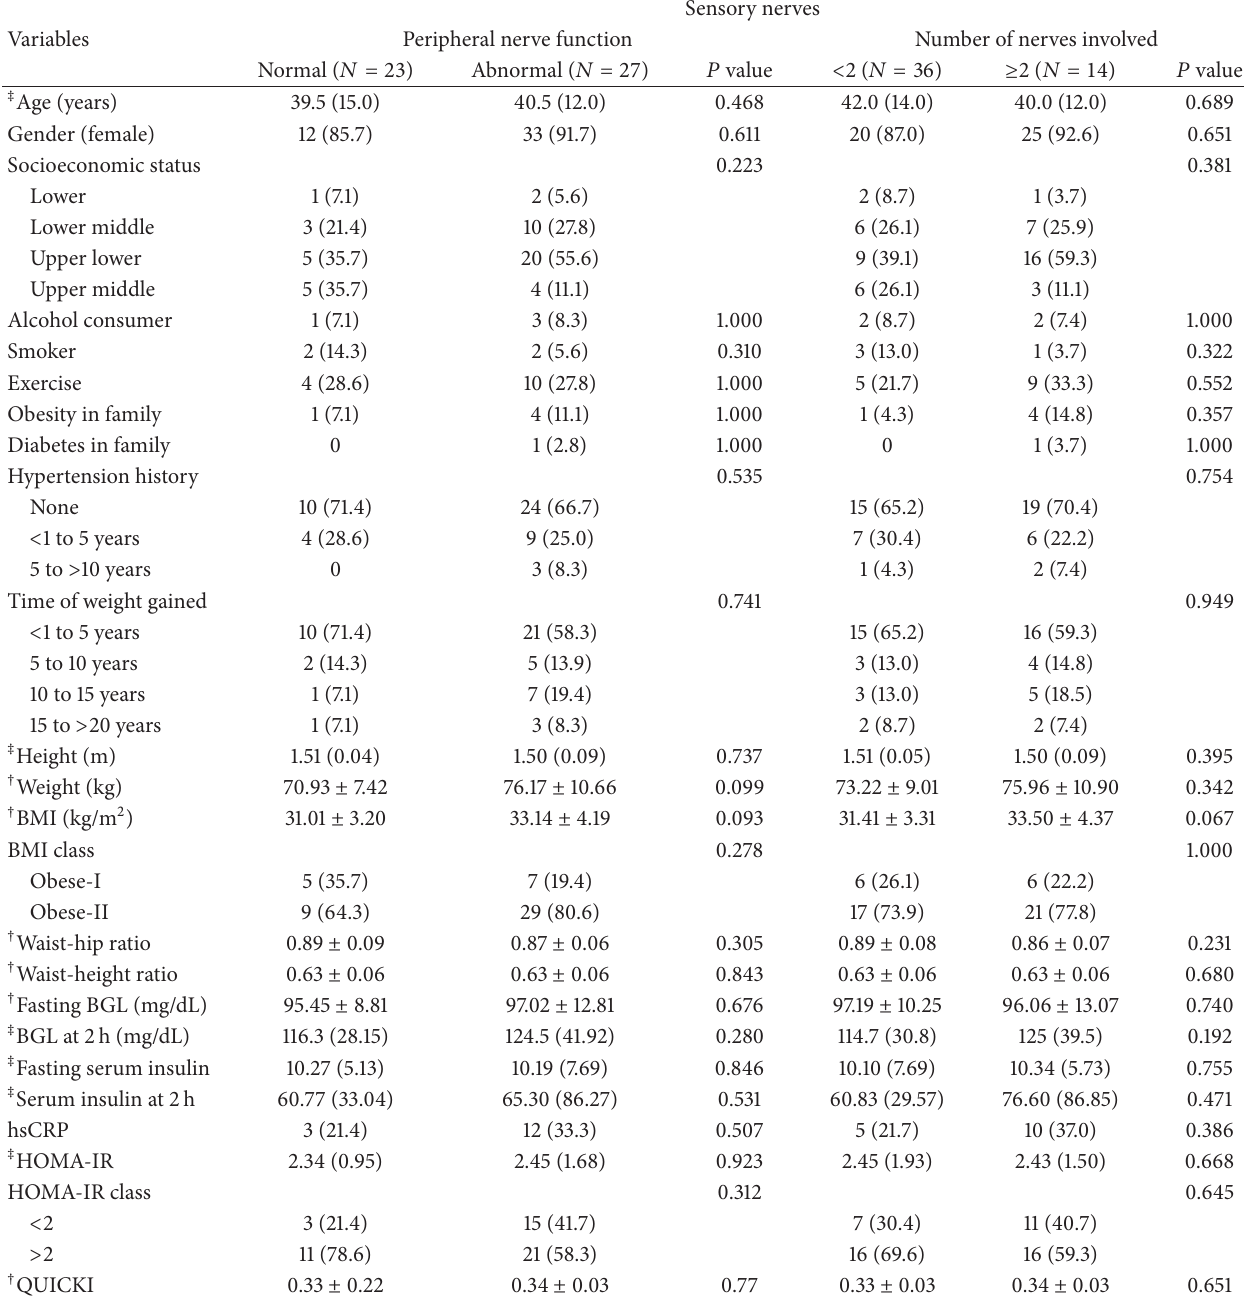
Table 3: Baseline characteristics of volunteers according to the sensory nerve. The values in the column of the sensory nerves outside the small bracket are the count per total and those inside the bracket are the